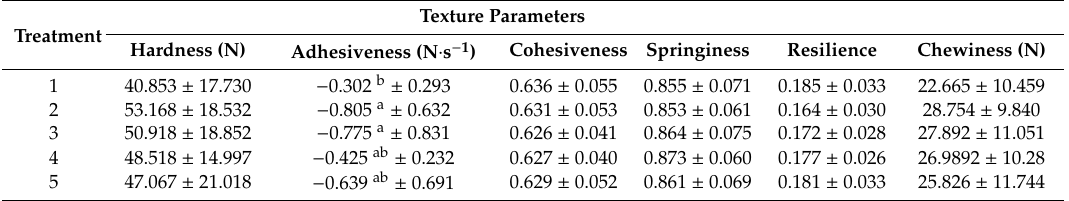
Table 5. E ff ect of starter cultures on textural parameters of smoked fermented sausages evaluated in